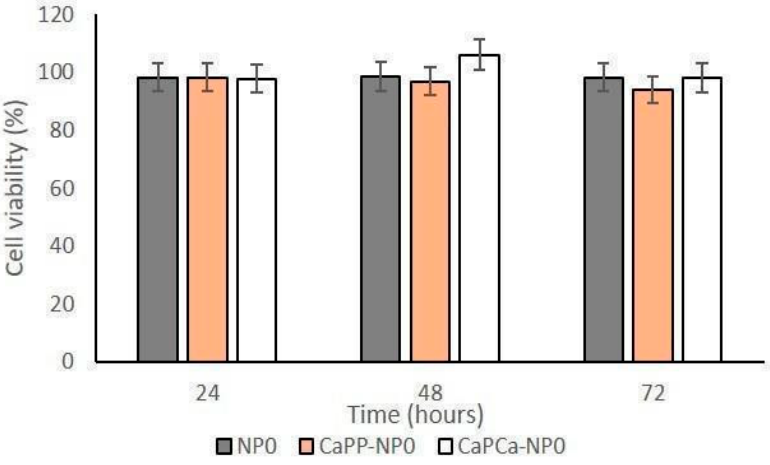
Figure 6. D17 cells were incubated with NP0, CaP P -NP0, and Cap Ca -NP0, diluted 1:10 (1000 µg/mL trilaurin) in the cell culture medium, for 24, 48, and 72 h. Cell viability was measured using the MTT assay. Results are means + SD ( n = 0.3).